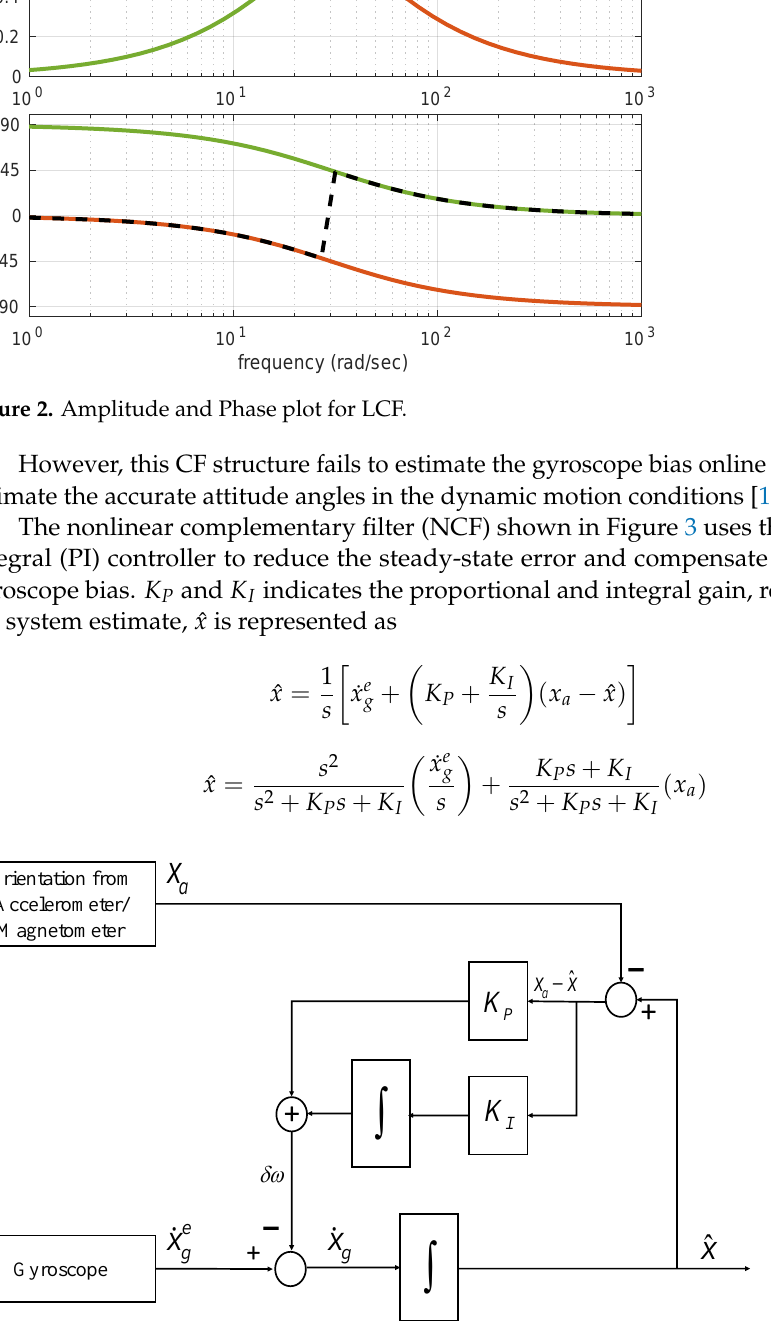
Figure 3. Nonlinear structure of Complementary